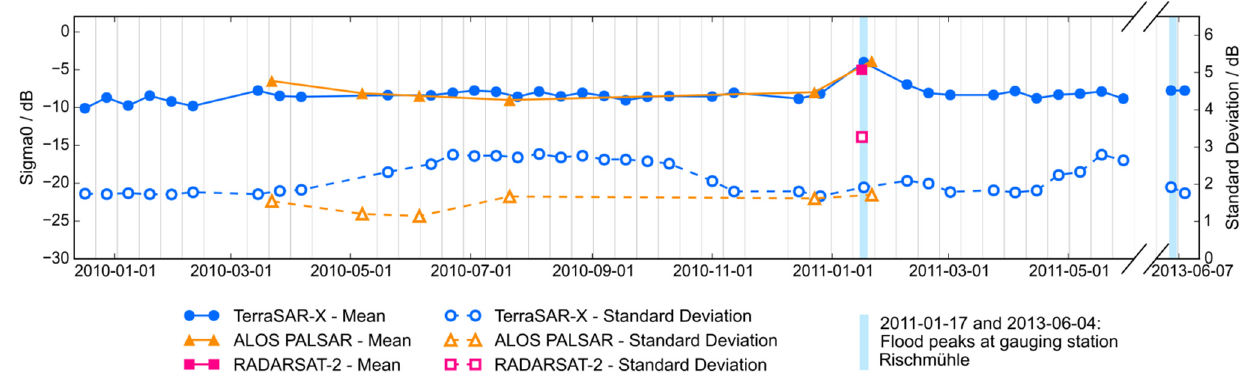
Figure 5. Time course of σ 0 (dB): Mean and standard deviation for test class 2 (Deciduous forest, dense, flooded).